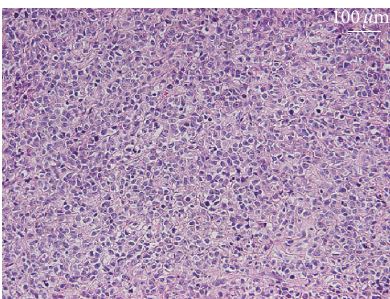
Figure 4: The specimen of the rib excised in 2007 showing cellular atypia and prominent nuclear pleomorphism.